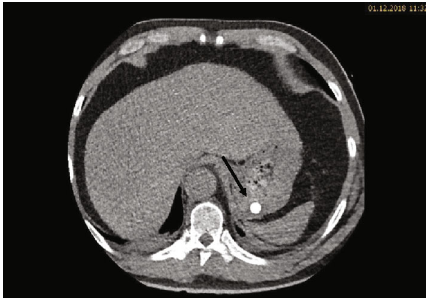
Figure 2: Transversal slide of the abdominal CT in the arterial phase: a sharply demarcated structure in the stomach is